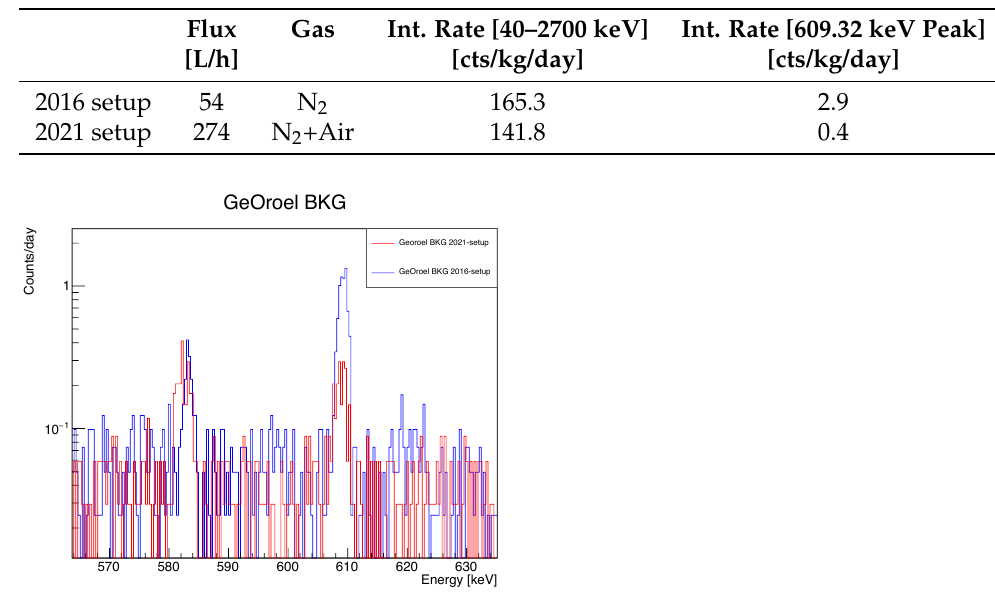
Figure 24. GeOroel background comparison, 214 Bi 609.32 keV peak of reduction. In blue 2016 setup vs. in red